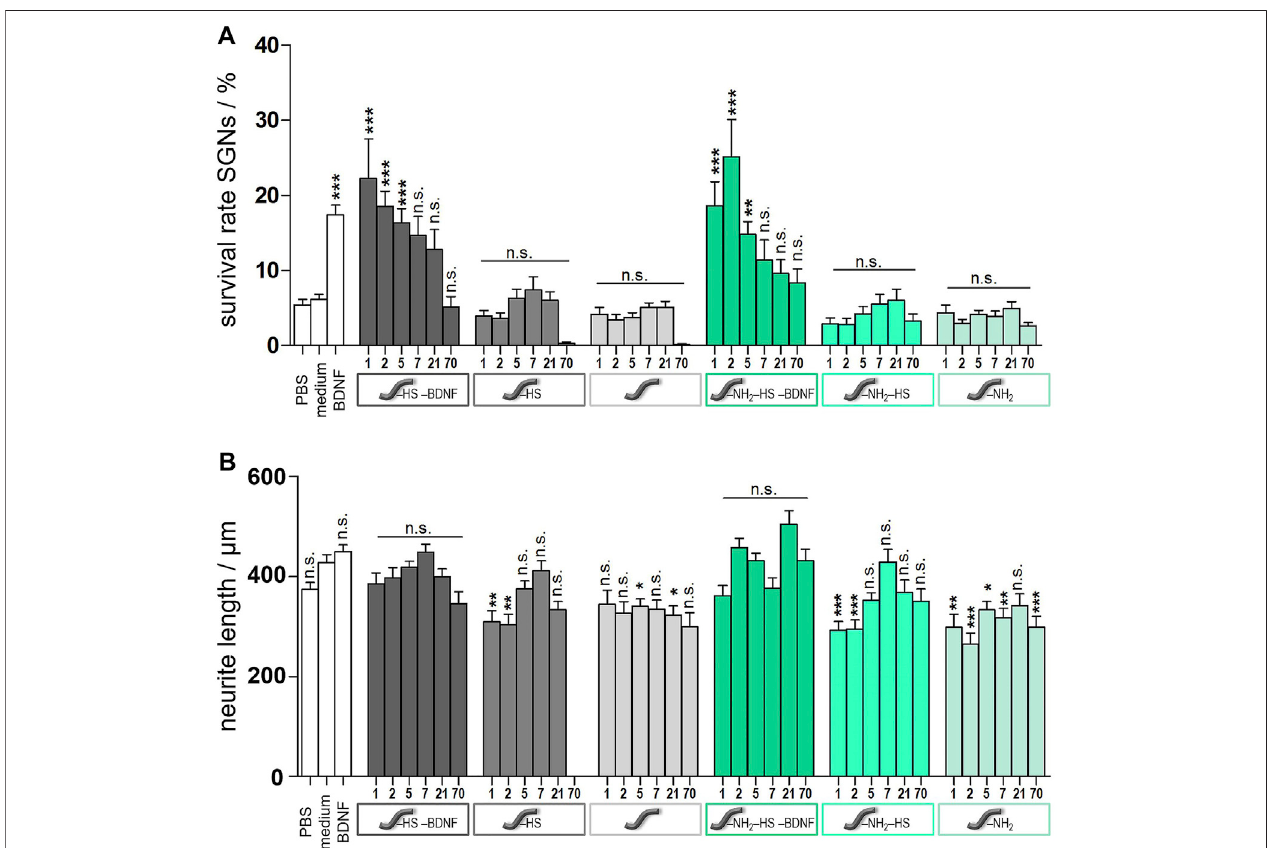
FIGURE 13 | Results from spiral ganglion cell culture studies after cultivation for 2 days. Cells were incubated with the supernatants from the release experiments of either unmodi fi ed (grey columns) or amino-modi fi ed (green columns) fi bers. Fibers carrying BDNF and HS are depicted in the darkest colour shades, thosecarryingonly HSaredepicted in medium colourshades, and thosenotfurther modi fi ed aredepicted inthelightestcolour shade. Valuesfor controls are shown as white columns (PBS and medium as negative controls, medium with added BDNF as positive control). (A) Survival rates of spiral ganglion neurons. (B) Neurite lengths of survived SGNs. Values are given as mean ± standard error of the mean ( N (cid:1) 3, n (cid:1) 3). Statistical assessment was performed using one-way ANOVA with Tukey ’ s Multiple comparison test (n.s. (cid:1) not signi fi cant, * p < 0.05; ** p < 0.01; *** p < 0.001). Asterisks over the bars indicate the signi fi cance of the survival rates of different conditions compared to the medium (serum-free SGN medium) and PBS control (as the results obtained for both cases are very similar to each other) as well as the signi fi cance of the neurite lengths of different conditions compared to the medium control.